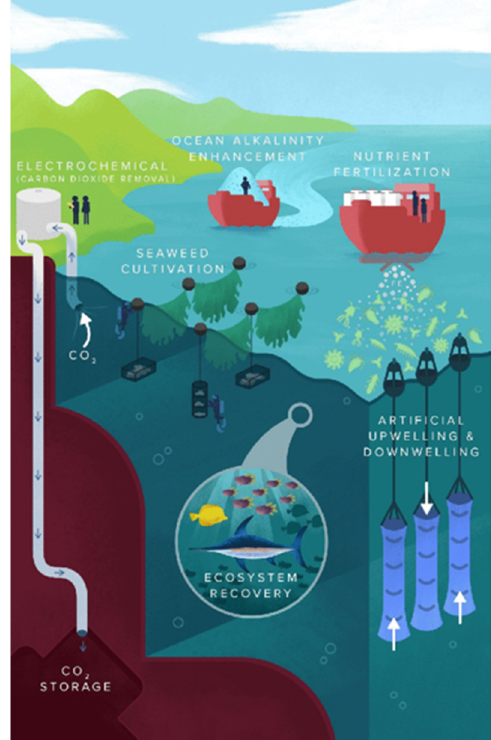
Figure 2. Strategies for ocean CO 2 removal. Credit: National Academies of Sciences, Engineering, and Medicine. 2021. A Research Strategy for Ocean-Based Carbon Dioxide Removal and Sequestration. https://doi.org/10.17226/26278 (accessed on 9 February 2022). Reproduced with permission from the National Academy of Sciences, courtesy of the National Academies Press, Washington, DC, USA.